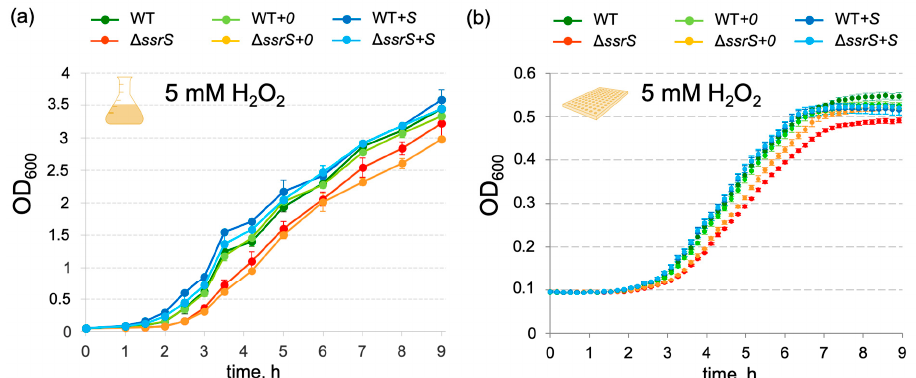
Figure 3. Complementation of the 6S RNA knockout strain by a plasmid-borne ssrS gene rescues the growth defect. ( a ) Growth curves of E. coli strains in the presence of 5 mM H 2 O 2 either during cultivation in flasks with manual monitoring of optical density (OD 600 ) or ( b ) in 96-well plates using an automated scanning reader; based on 3 biological replicates in each type of